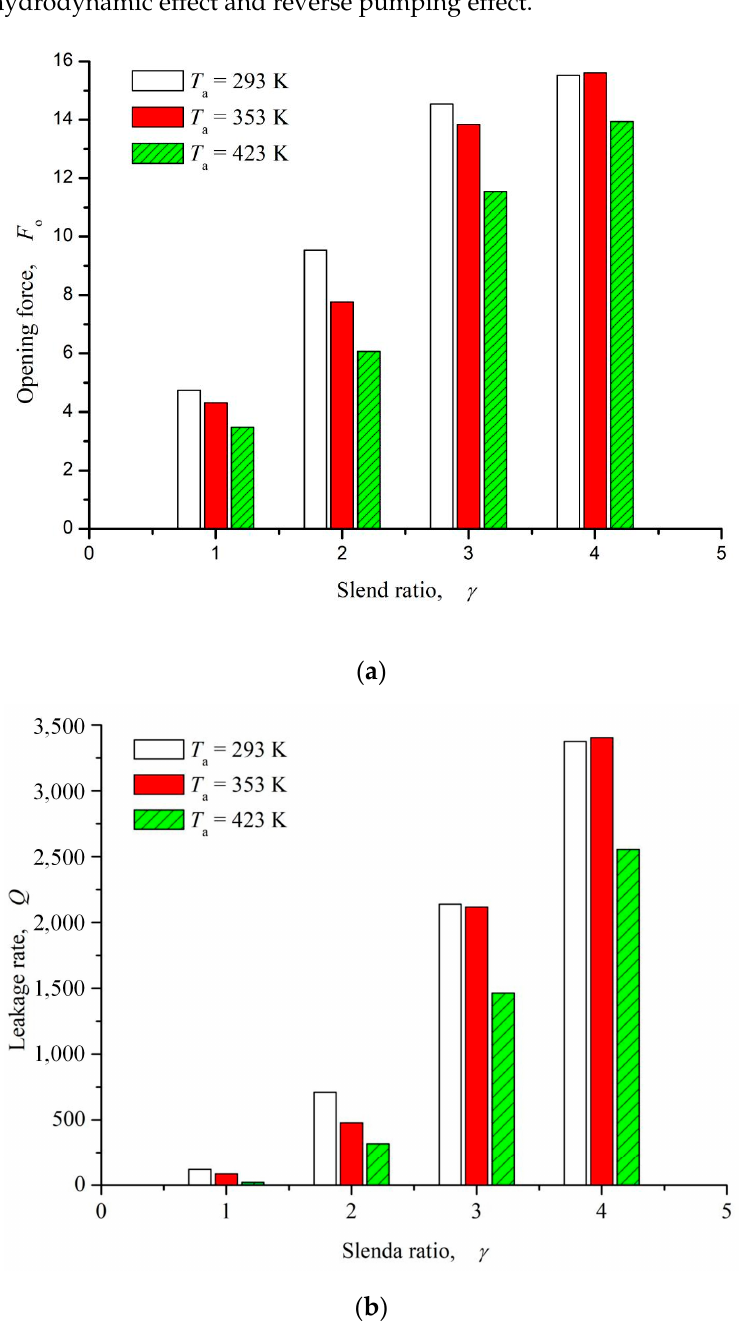
Figure 13. In fl uence of slender ratio on opening force and leakage rate ( ω = 12,000 rpm, P o = 4, h 0 = 2 μ m, h d = 5 μ m, α = 45°, N = 80). ( a ) Opening force. ( b ) Leakage rate.